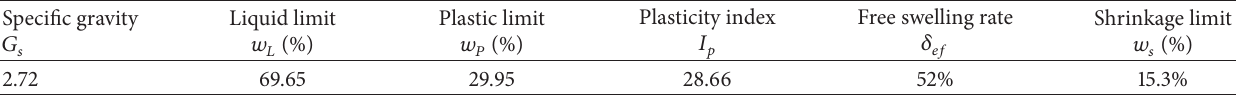
Table 1: Basic physical properties of soil